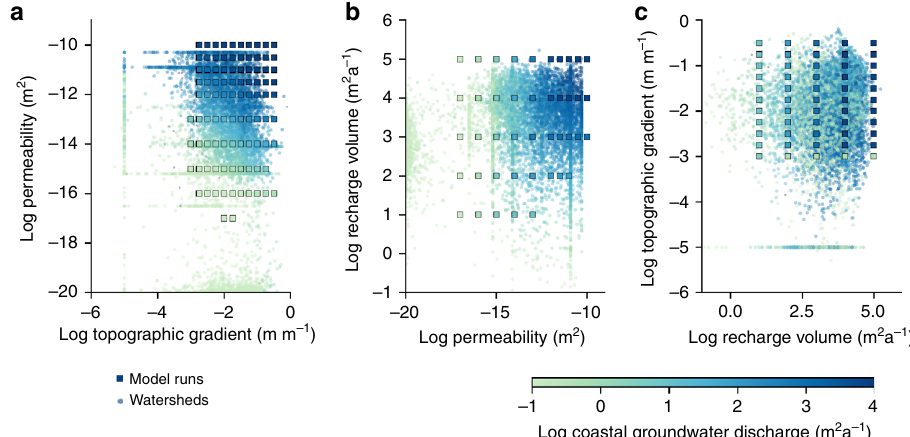
Fig. 2 Illustration of the linear interpolation method used to quantify coastal groundwater discharge at a global scale. This fi gure shows the interpolation of coastal groundwater discharge for each of the 40,082 global coastal watersheds from a series of 351 model runs that cover the range of permeability, topographic gradients and groundwater recharge found in these watersheds. Each dot represents the parameter values for permeability, topographic gradient and recharge volume for a single coastal watershed, which were derived from a global geospatial analysis (see Methods section). The watersheds are colored by their interpolated value of coastal groundwater discharge. Each square represents a single numerical model run. Each panel shows the parameter values and interpolated CGD for a pair of parameters; permeability and topographic gradient ( a ), permeability and recharge volume ( b ) and recharge volume and topographic gradient ( c ). Note that in each panel there are a number of model runs (squares) that overlap. In each case the model run is shown with the highest modeled coastal groundwater discharge. For instance, for panel a behind each square there are a number of additional model runs that are not shown that used different recharge volume values. The results of the model experiments can be found in Supplementary Data 2. The geospatial data of coastal watersheds and the interpolated values of coastal groundwater discharge are available as Supplementary Data